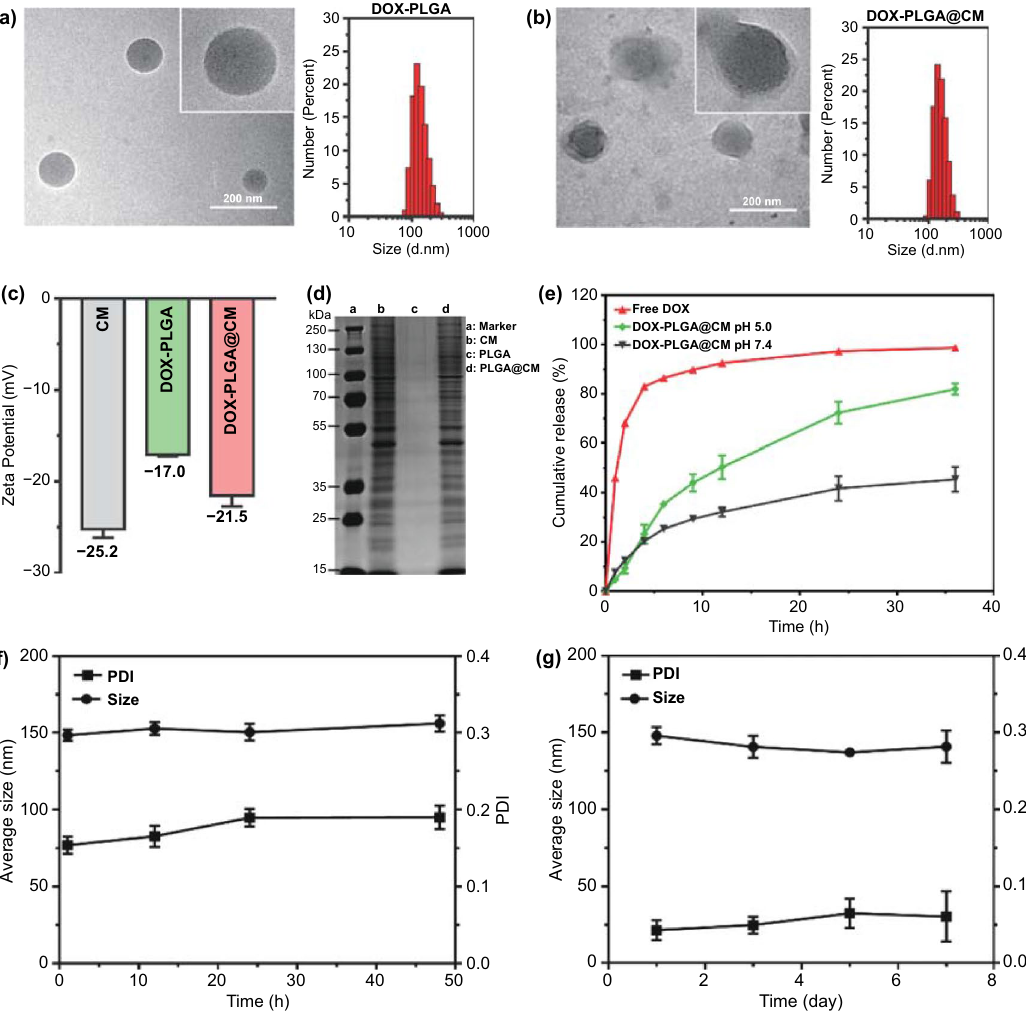
Fig. 1 Characterization of DOX‑PLGA@CM. TEM and DLS size distribution of DOX loaded PLGA nanoparticles (DOX‑PLGA) a and MDA‑ MB‑231/Br cell membrane (CM) coated DOX‑PLGA nanoparticles (DOX‑PLGA@CM) b . c Zeta potential of CM, DOX‑PLGA, and DOX‑ PLGA@CM. d The protein analysis of CM vesicle (lane b), PLGA nanoparticles (lane c), and PLGA@CM (lane d) by SDS‑PAGE. Lane a is the protein marker. e DOX release profiles from DOX‑PLGA@CM. f The colloidal stability of DOX‑PLGA@CM in PBS containing 10% FBS at 37 °C, and g Stability of DOX‑PLGA@CM in PBS at 4